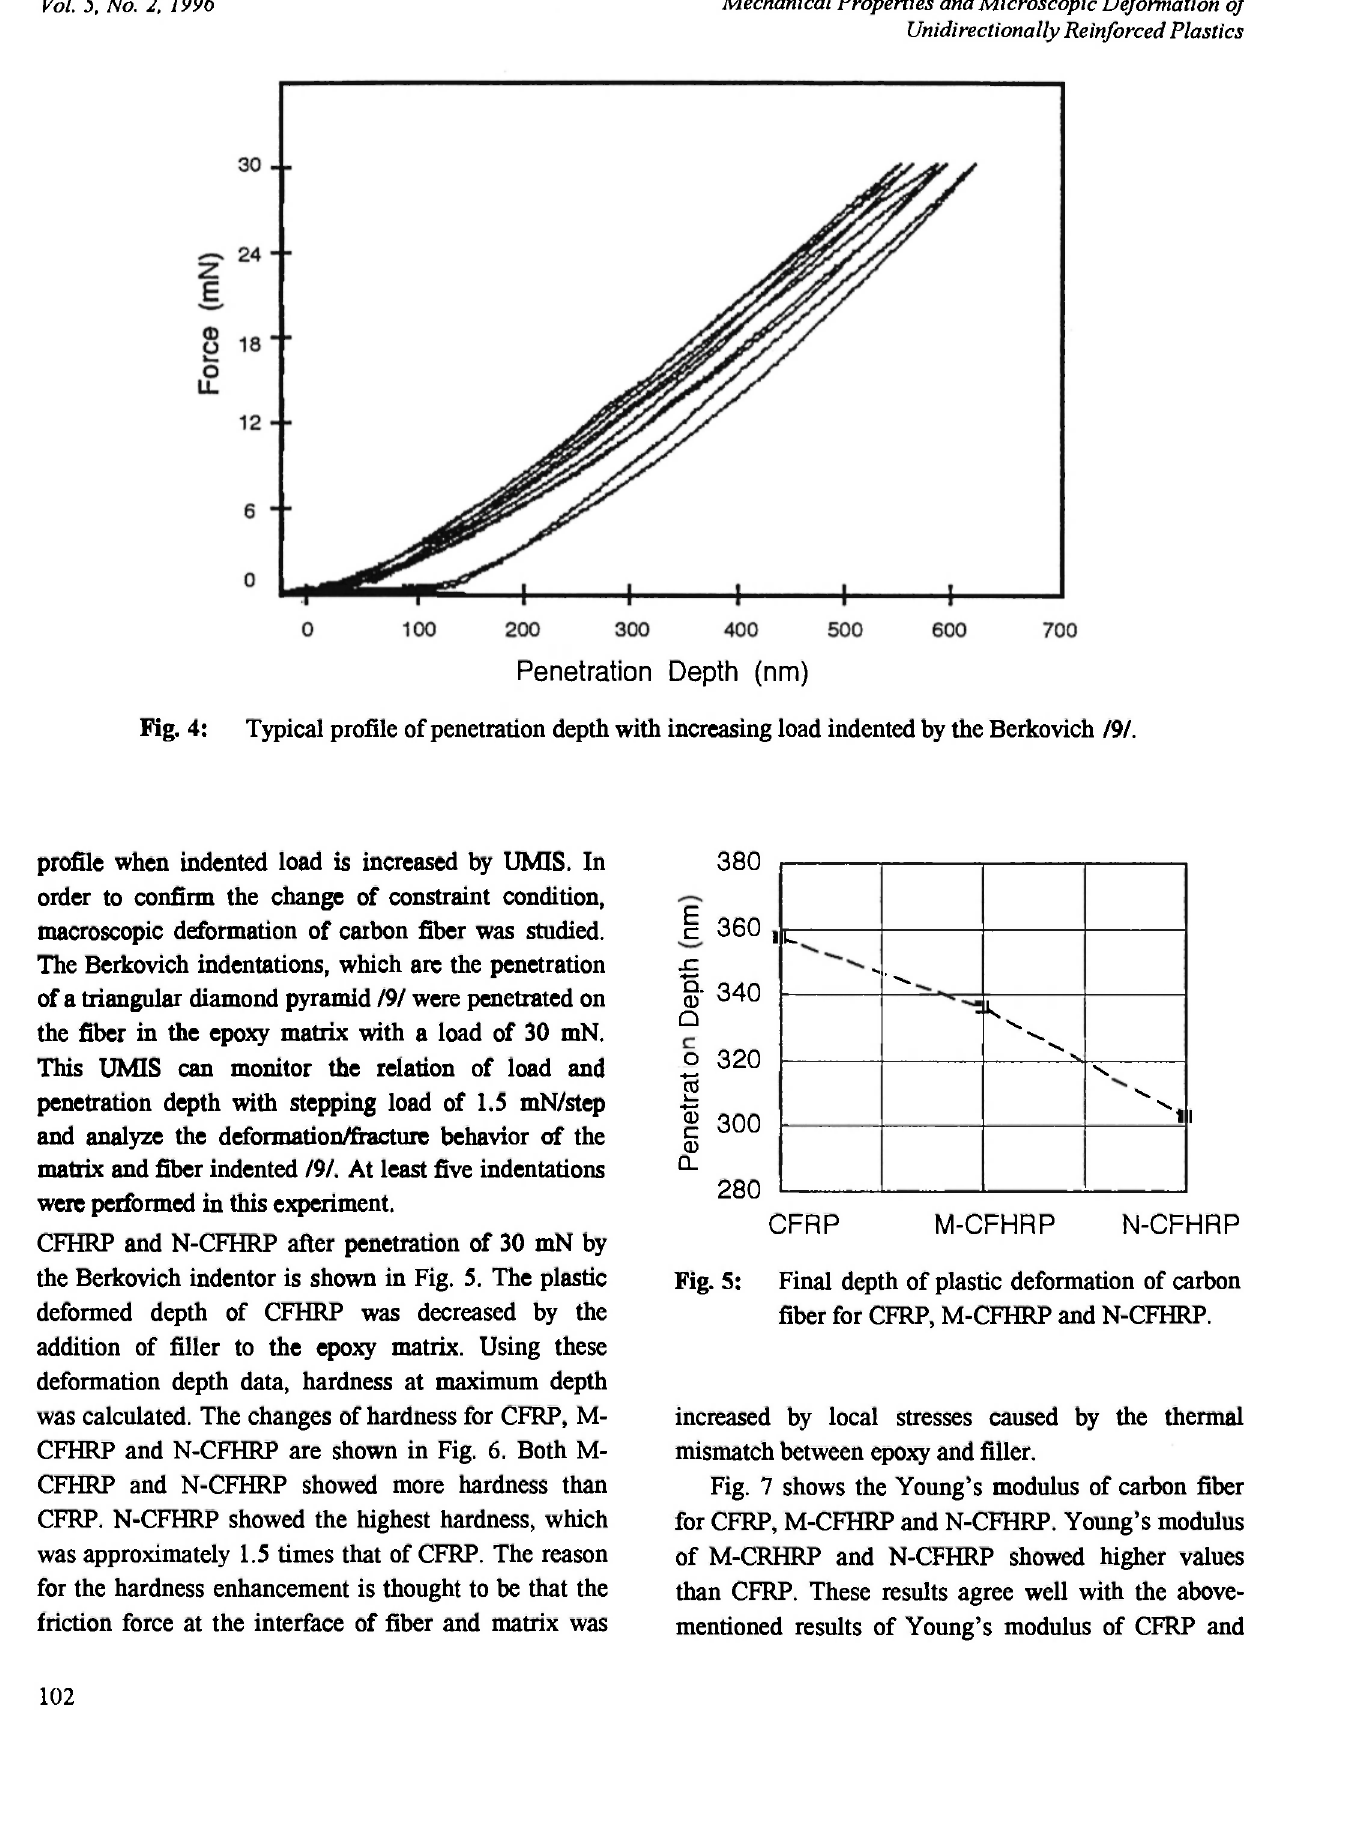
Fig. 5: Final depth of plastic deformation of carbon fiber for CFRP, M-CFHRP and N-CFHRP.